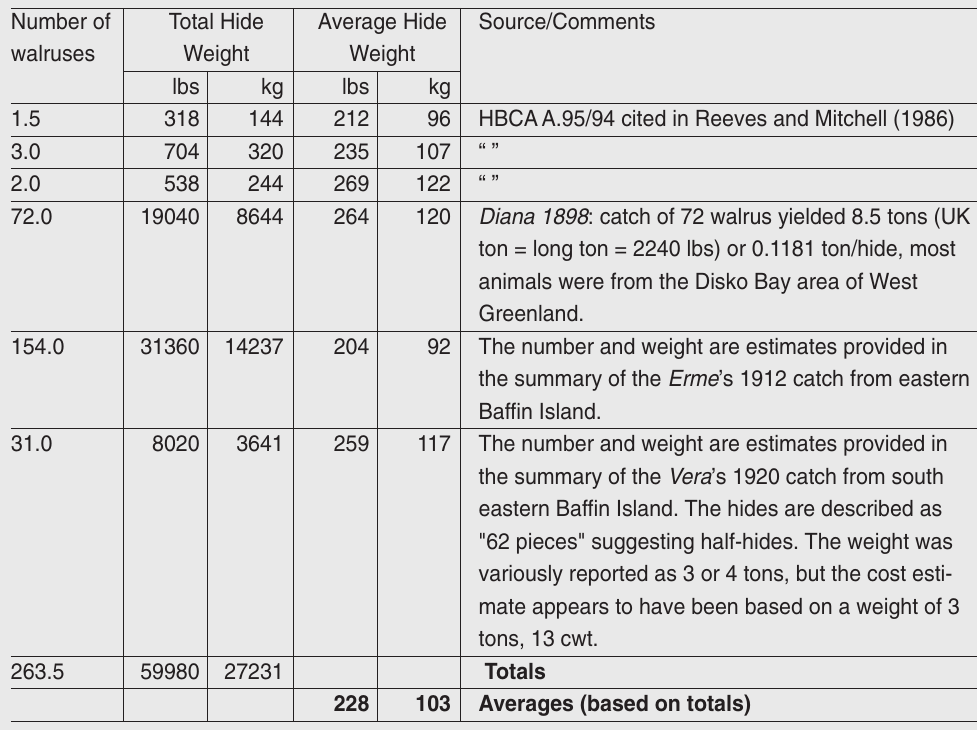
Table 2. Conversion factor for estimating walrus catches based on the reported hide weights, using data from hunts in Baffin Bay and Davis Strait. Number of Total Hide Average Hide